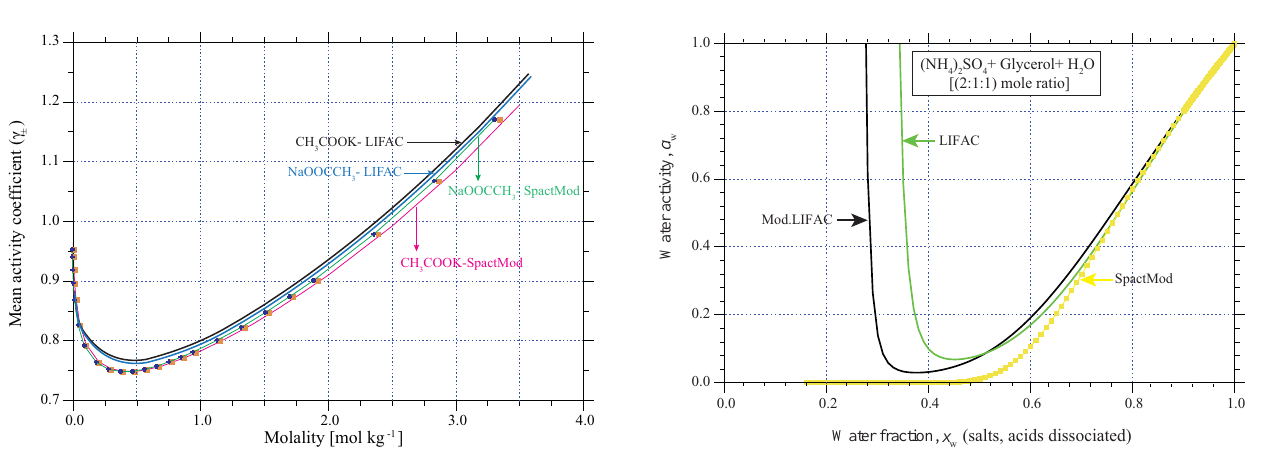
Figure 8. Comparison between experimental (symbols) and calcu- lated mean activity coefficients (solid lines) of binary salt mixtures as a function of molality (molkg − 1 ) at 298K. Experimental data are taken from Hamer and Wu (1972).